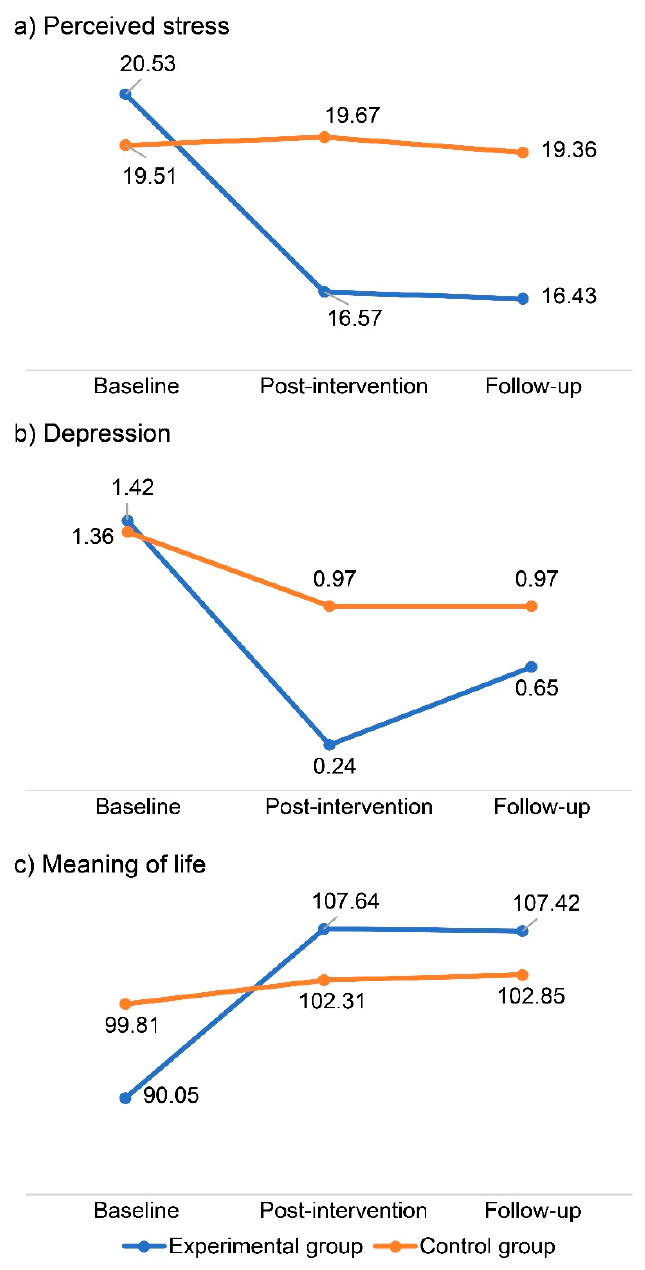
Figure 2. Outcome changes in group comparison; effect of the LAC on ( a ) perceived stress, ( b ) depression, and ( c ) meaning of life. The estimated mean is represented. Table 3. Effects of logotherapy on participants’ stress, depression, and meaning of life ( n = 48).